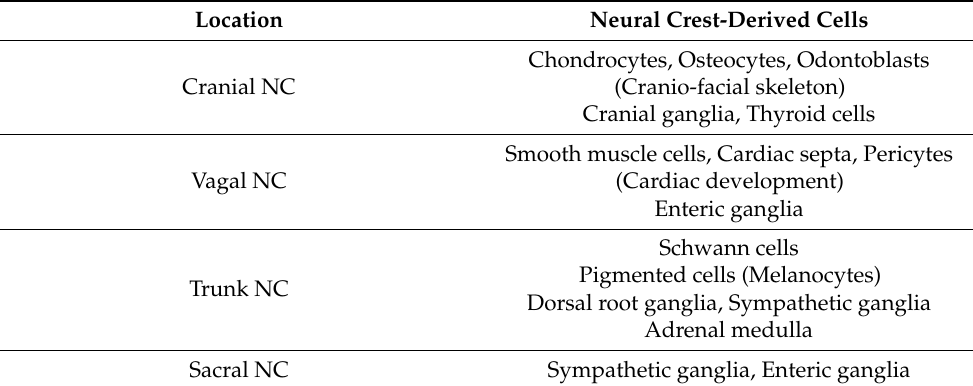
Table 1. Neural crest (NC) cell populations’ localization, and major derivates during embryologic